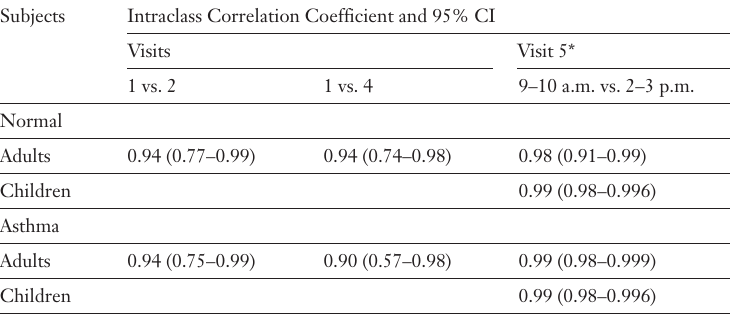
Statistical comparison of the reproducibility of FE NO measurements between 1st & 2nd vs . 1st & 4th and morning vs . Afternoon visits. Subjects